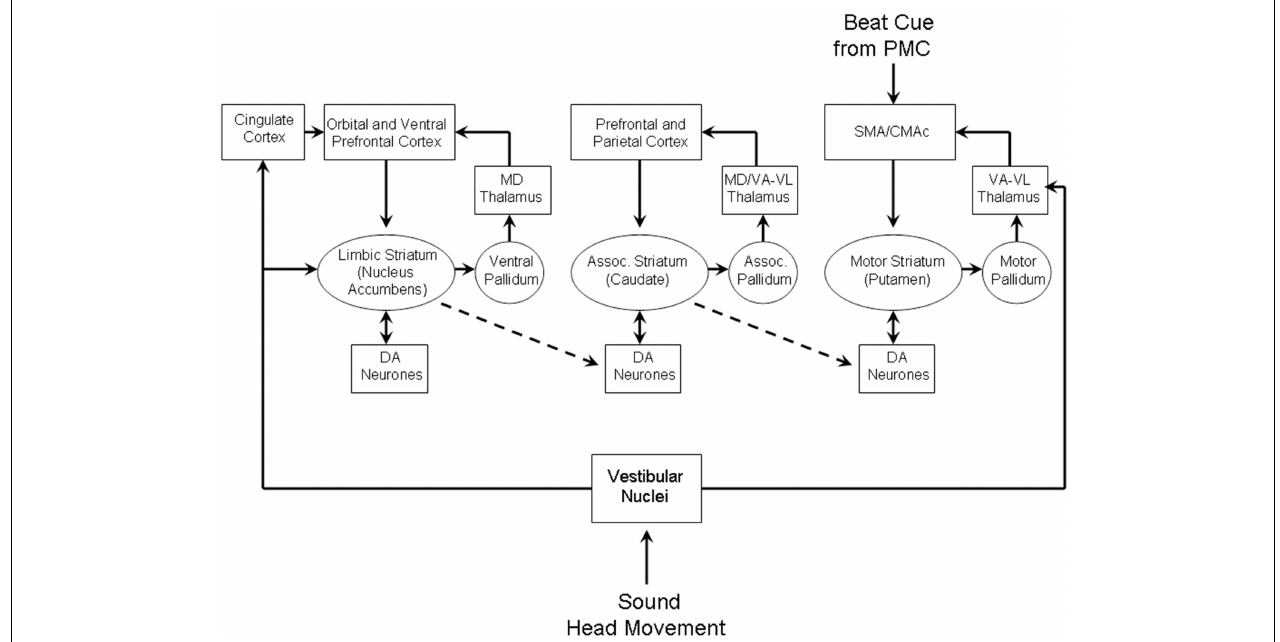
FIGURE 9 | Cortico-basal ganglia networks which may mediate vestibular habit formation. Adapted from Figure 3 of Yin and Knowlton